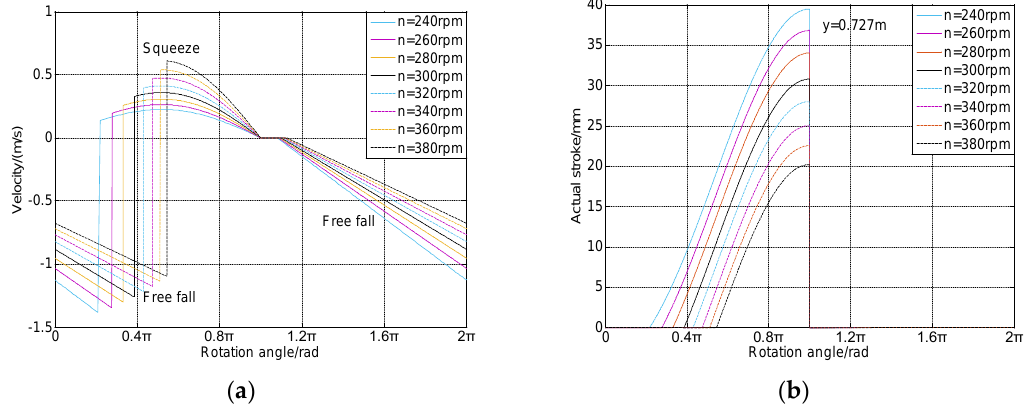
Figure 7. Squeezing velocity and actual stroke for various speed: ( a ) relation of speed vs. squeezing velocity; ( b ) relation of speed and actual stroke.